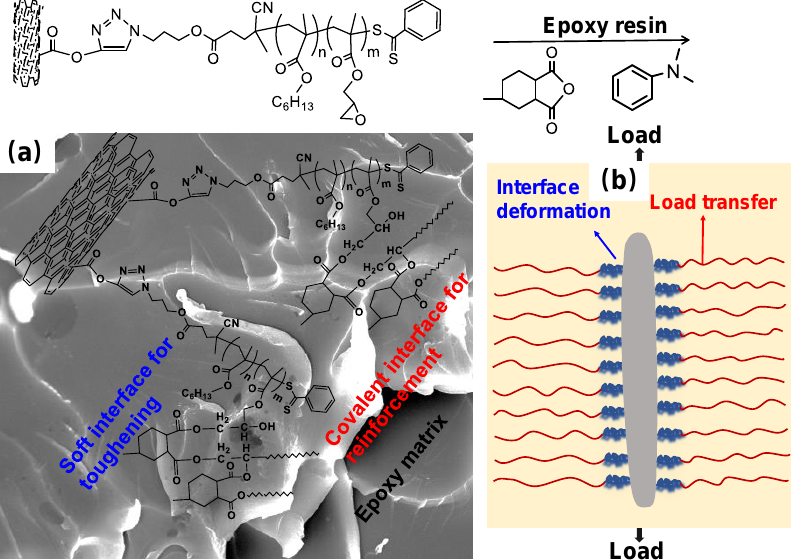
Figure 8. Proposed epoxy/bc@ f MWNTs nanocomposite formation mechanism ( a ), interphase struc- tures around MWNTs and their effects upon loading ( b ).